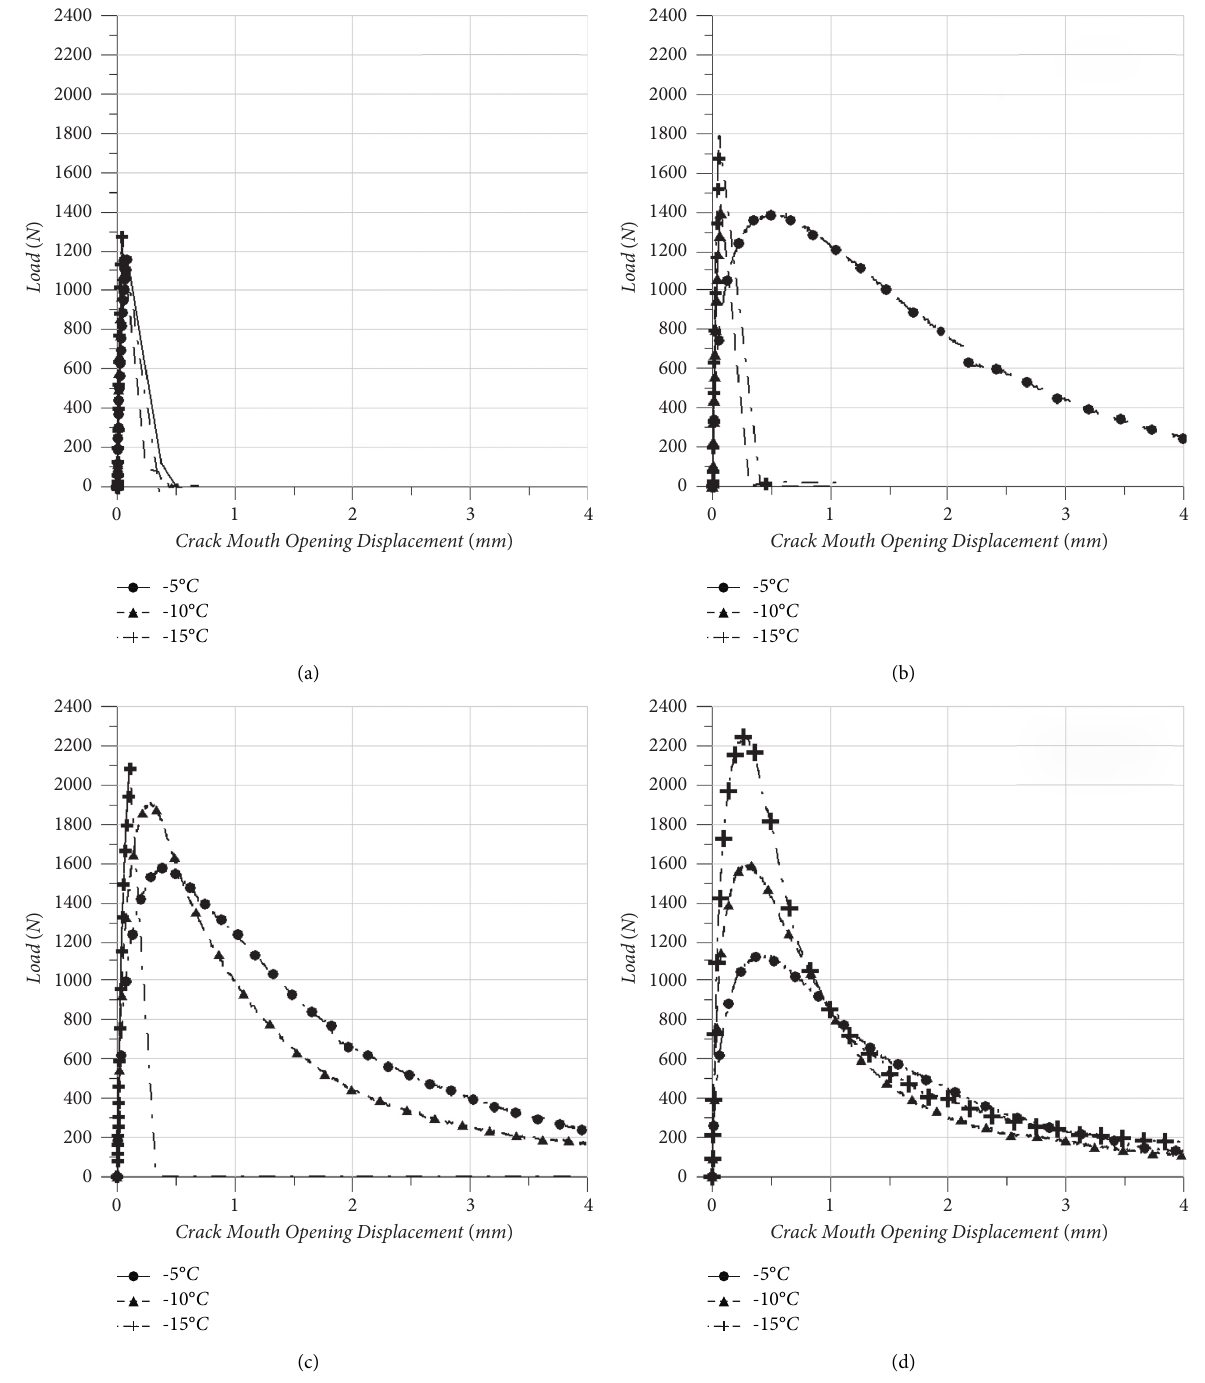
Figure 12: K Ic test results of the frozen sand with 0, 5, 10, and 15% fine contents vary with temperature: (a) fine contents 0%, (b) fine contents 5%, (c) fine contents 10%, and (d) fine contents